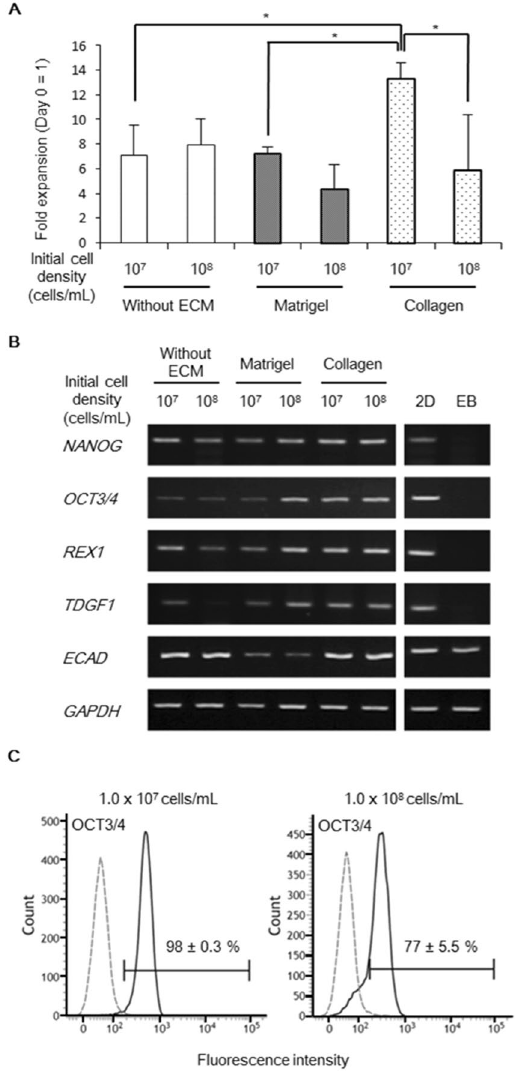
Figure 4. Optimization of the initial cell densities and the extracellular matrix (ECM) components in the core- shell microfibers. ( A ) Expansion rates of human iPS cells in the core-shell microfiber culture systems. The cells were retrieved on day 4, and their expansion rates were calculated (N ≥ 3). * P < 0.05. ( B ) Reverse transcription polymerase chain reaction (RT-PCR) analysis of the pluripotency-associated marker genes expression in cells cultured in six types of human iPS cell-laden core-shell microfibers for 4 days. 2D, cells cultured on a Matrigel- coated culture plate (positive control) and EB, embryoid bodies cultured in differentiation medium (negative control). Full-length gels are presented in Supplementary Figure S9. ( C ) Flow cytometry analysis of OCT3/4 expression in cells cultured with collagen at initial cell density of 1.0 × 10 7 or 1.0 × 10 8 cells/mL for 4 days (N = 3). The black solid line and gray dashed line indicate stained cells and the negative control,